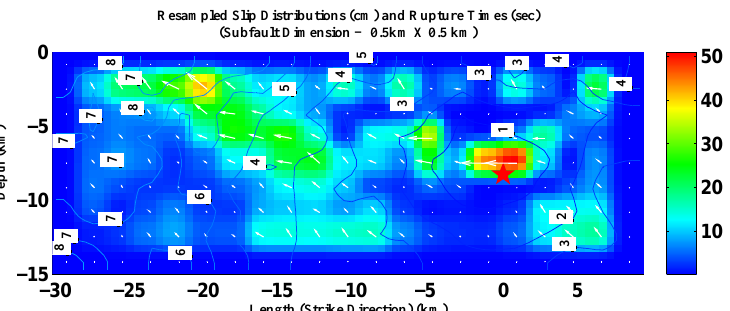
Figure 12. Resampled kinematic source model for the 2004 M w 6.0 Parkfield earthquake by [51]. Subfault dimension 0.5 km × 0.5 km. Color map: Slip distribution in centimeters. Arrows: Slip direction. Counters: Rupture times in seconds. Star: Hypocenter of the